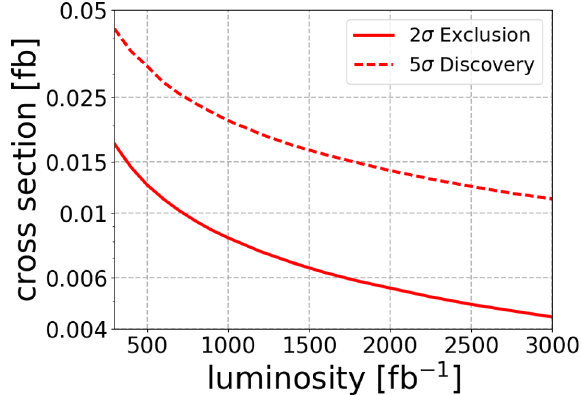
Figure 3 . The minimum signal cross-sections required for 2 σ exclusion and 5 σ discovery for luminosity ranging from 300 fb − 1 and 3000 fb − 1 at